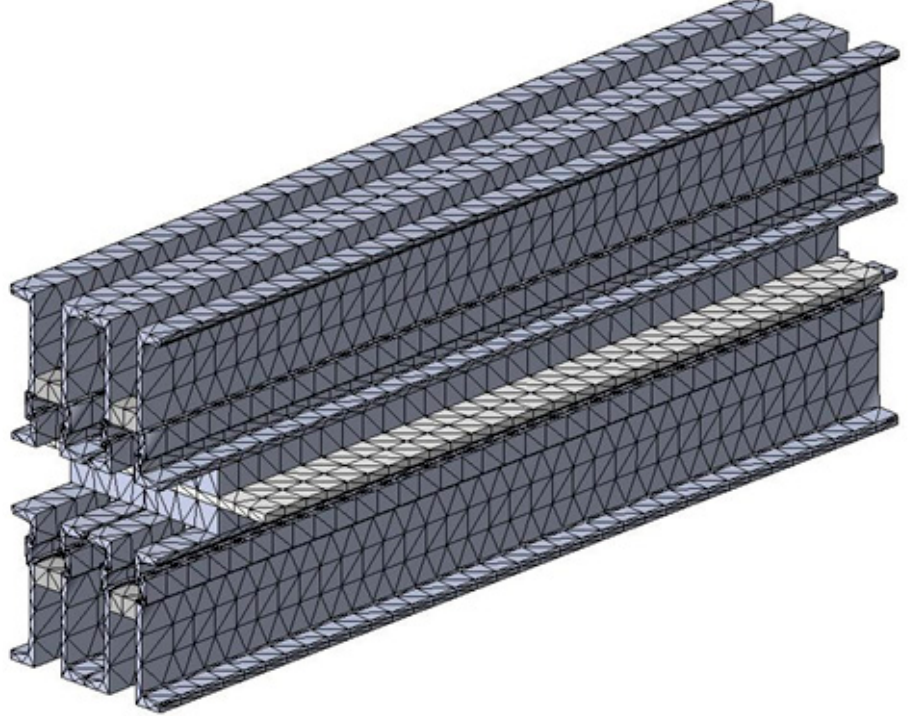
Materials 2019 , 12 , x FOR PEER REVIEW Figure 14. Discretion of the belt vulcanization press with the sti ff ening plate. Figure 14. Discretion of the belt vulcanization press with the stiffening plate.